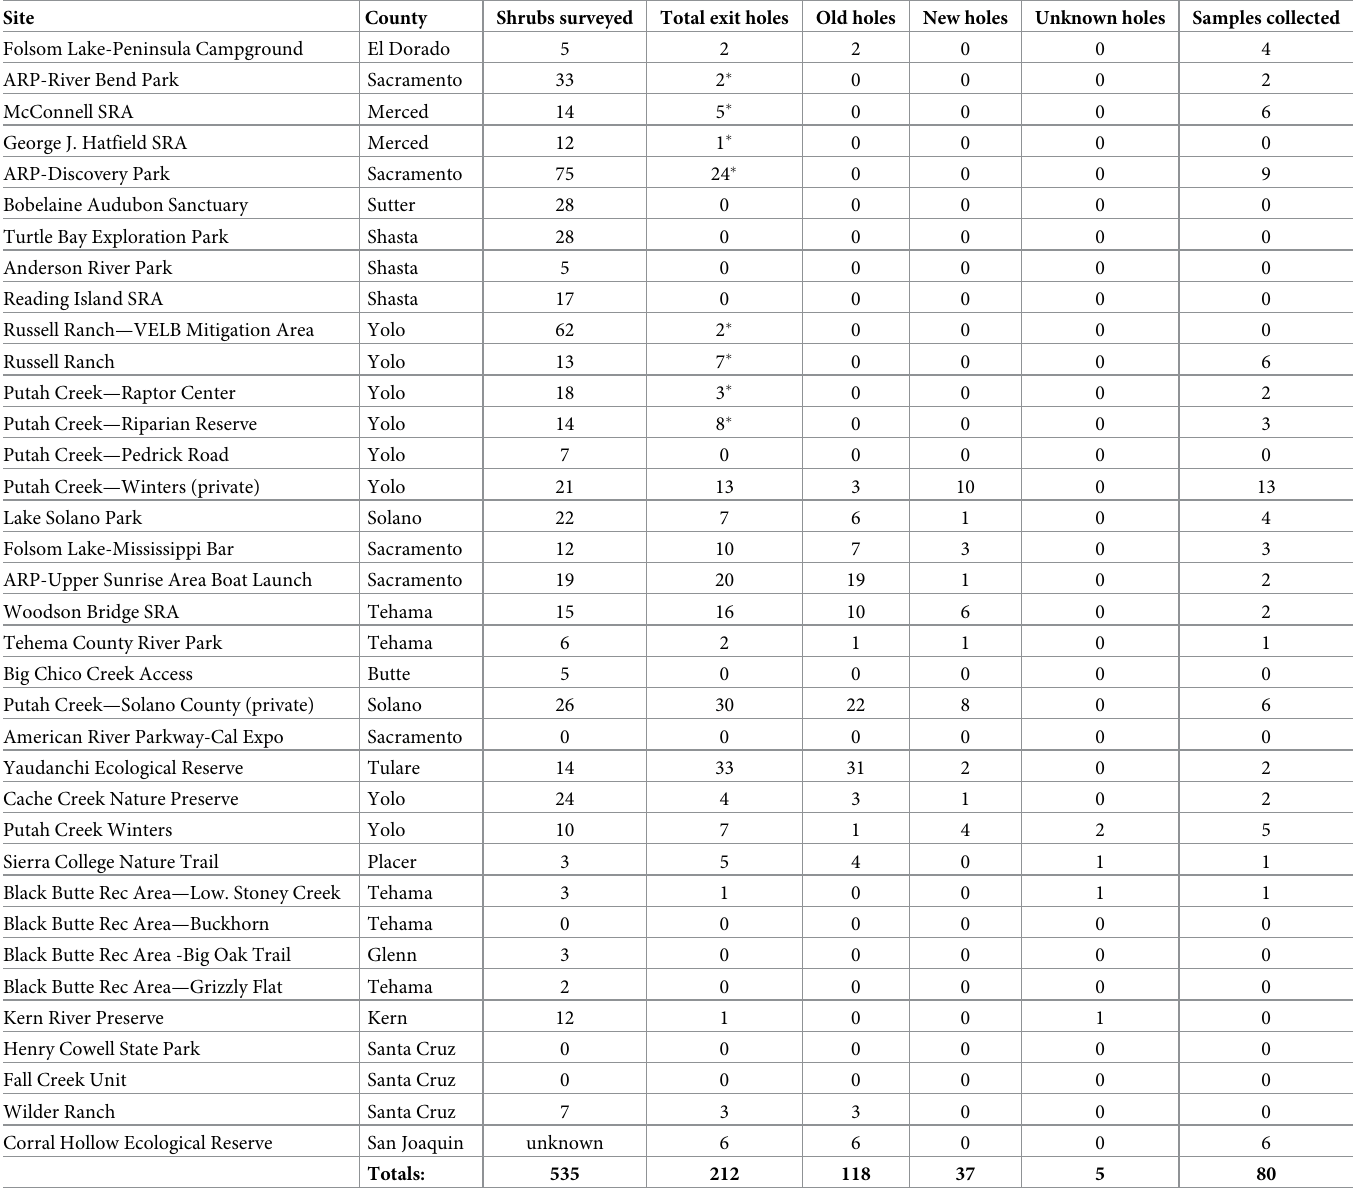
Table 1. Exit hole survey and frass